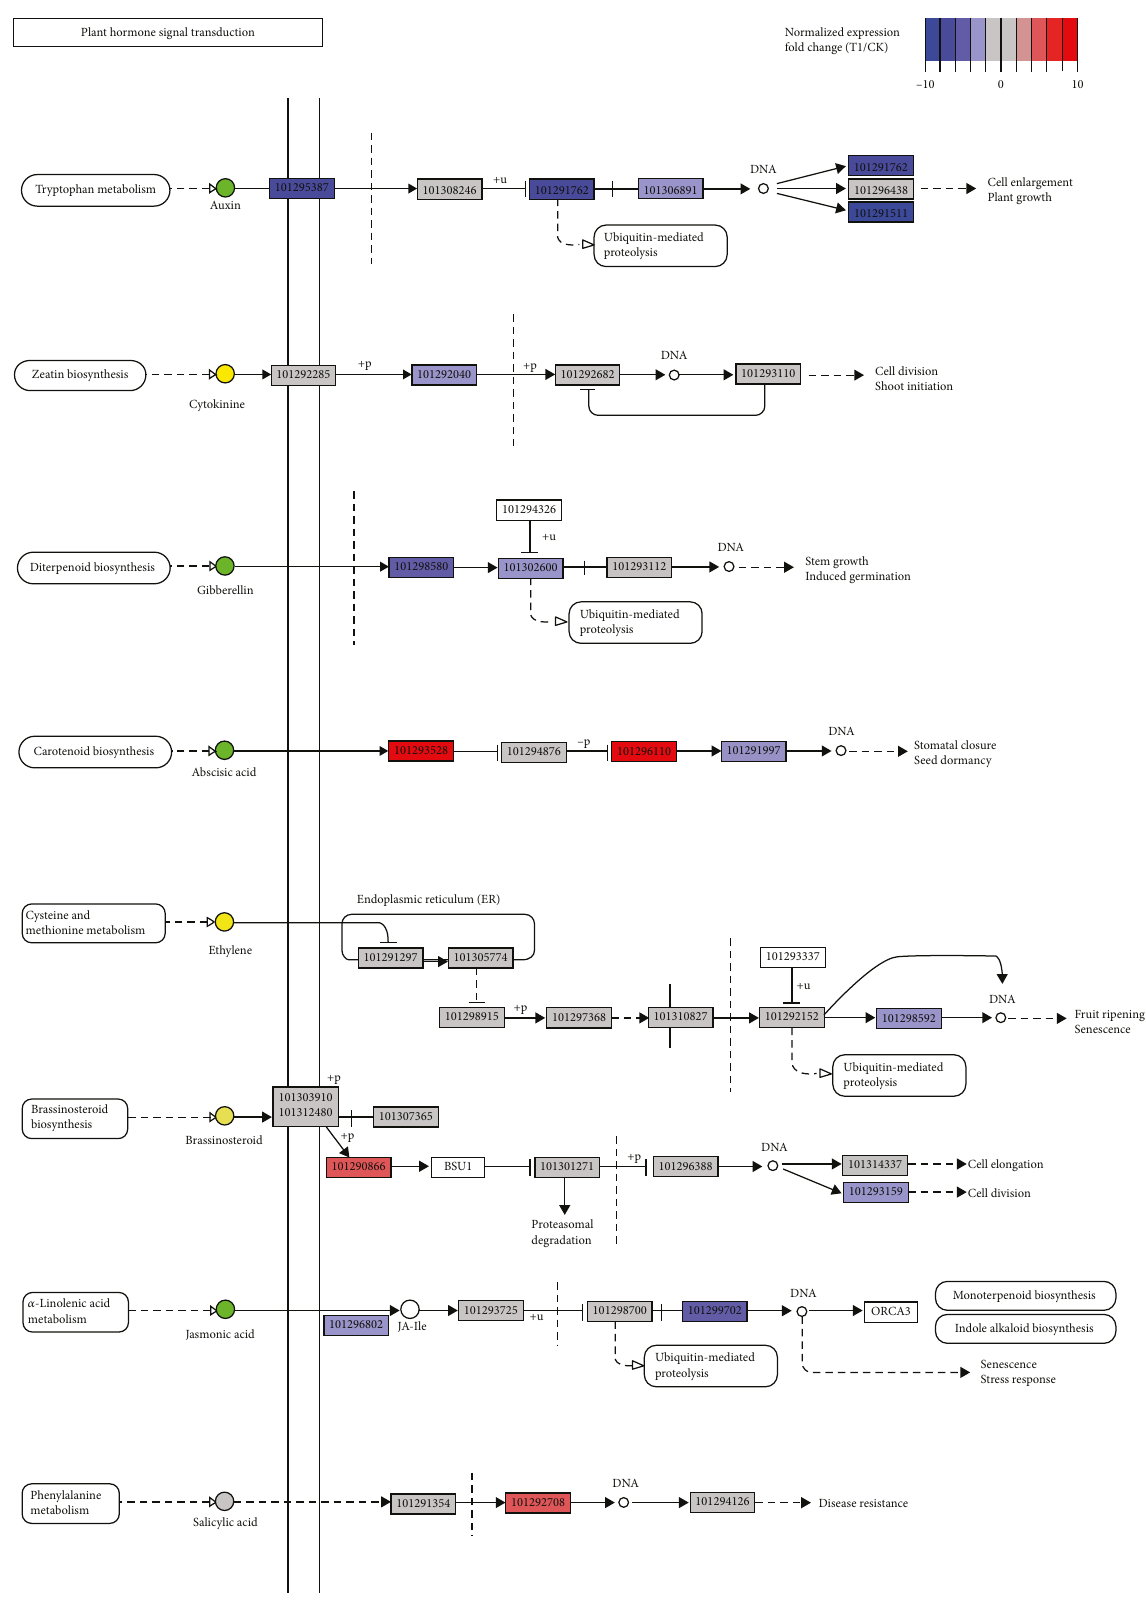
Figure 3: Hormone signaling pathways mapped with relative expression levels (T1 vs . CK). Gene ID of F. vesca is indicated at the corresponding gene node if there